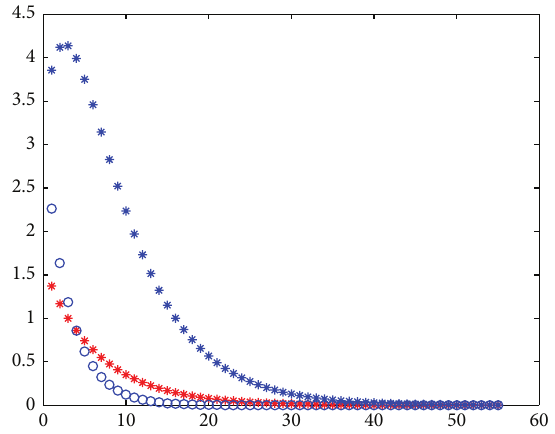
Figure 6: The errors of backward Guass-Seidel and Guass-Seidel